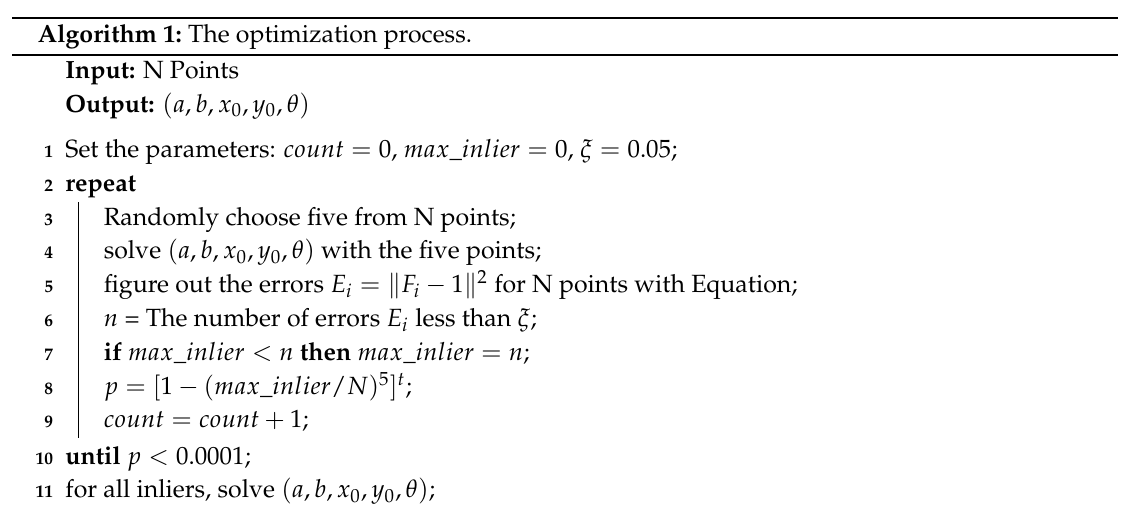
figure out the errors E i = (cid:107) F i − 1 (cid:107) 2 for N points with